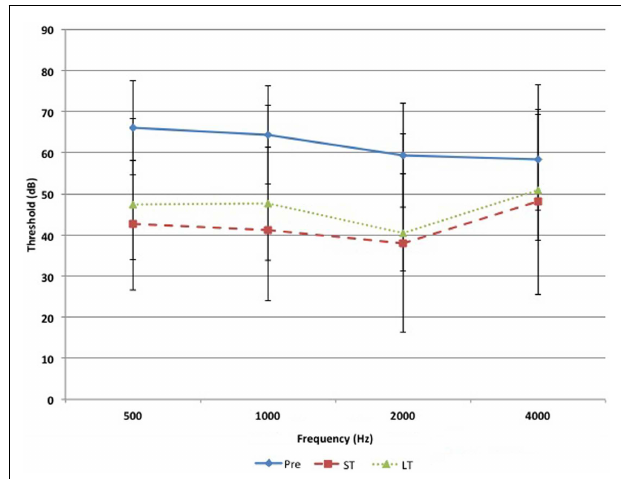
FIGURE 2 | Evolution of hearing threshold over time for EACR group .